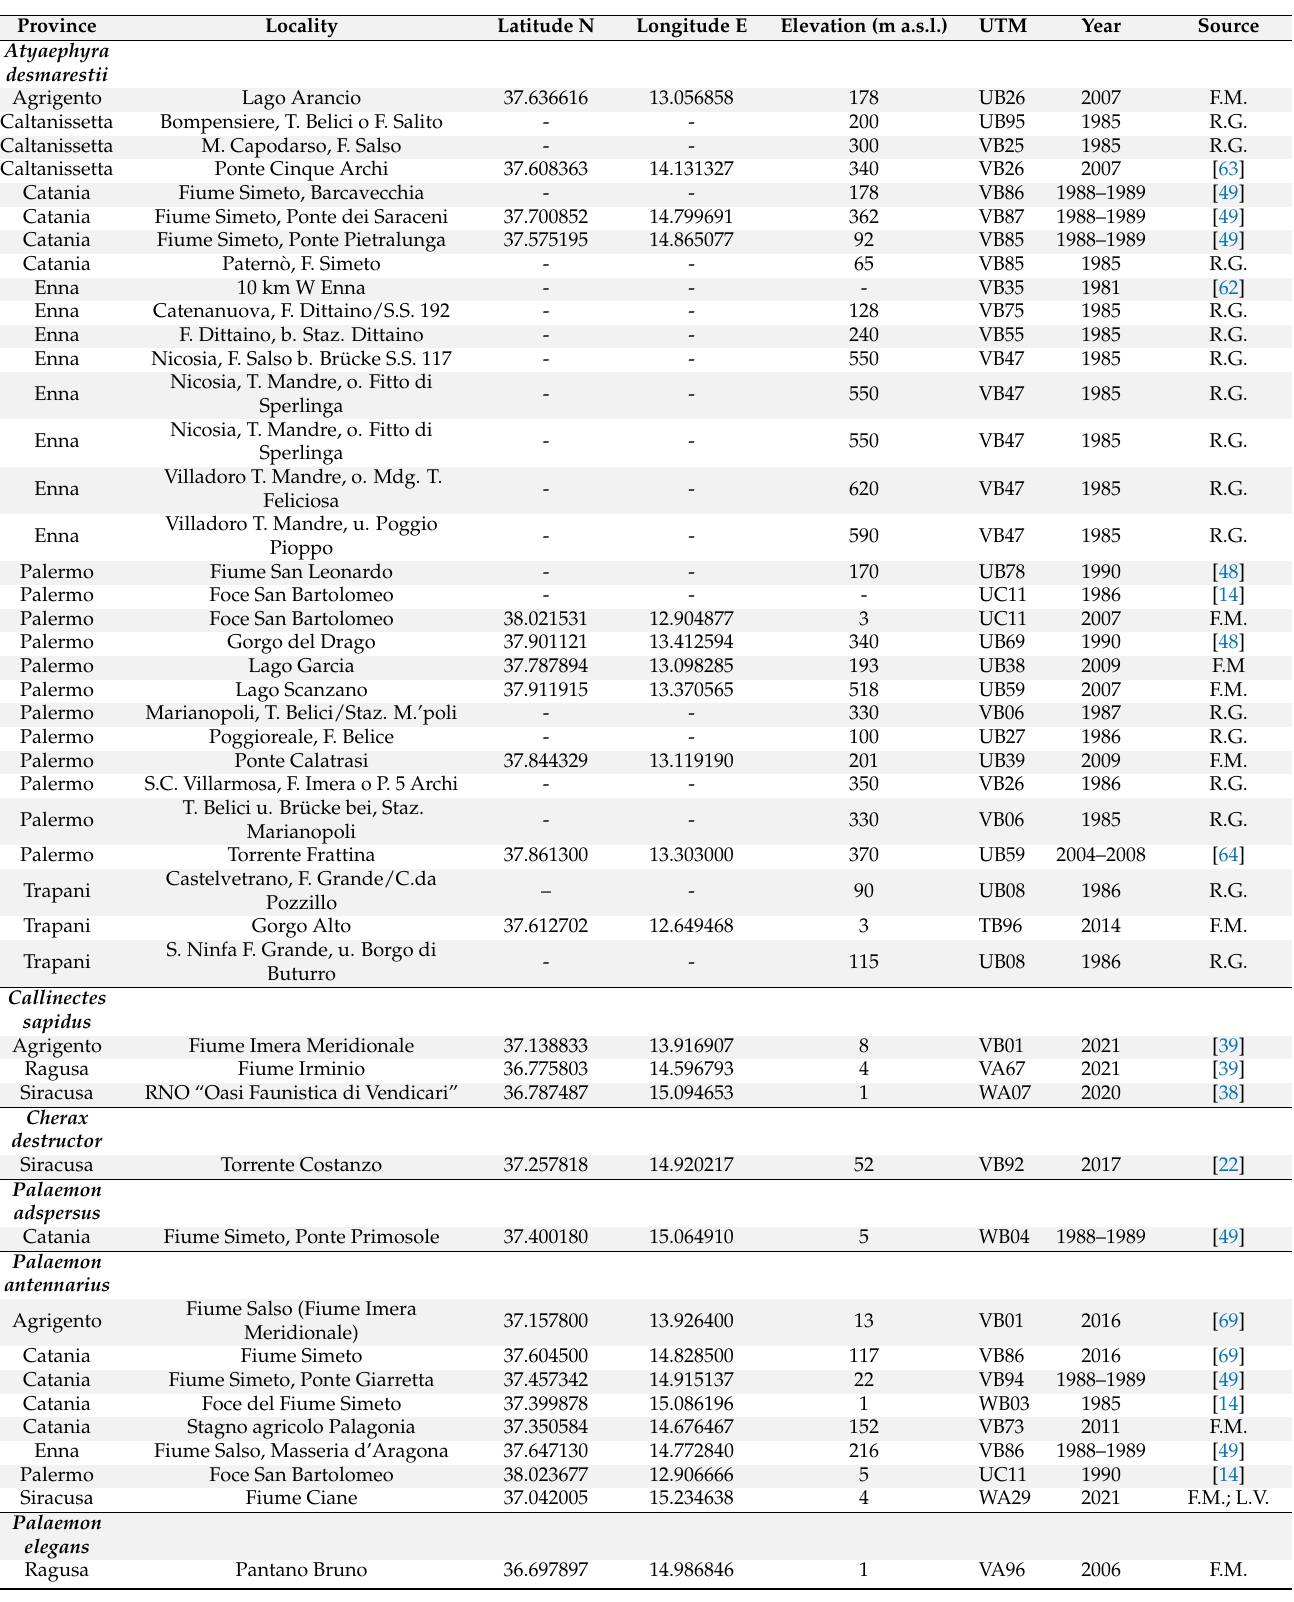
Table 1. List of the novel and published localities of the decapods occurring in Sicily. Geographical decimal coordinates are reported according to the WGS84 datum. UTM coordinates are reported by 10 × 10 km grid square (zone 33N, datum